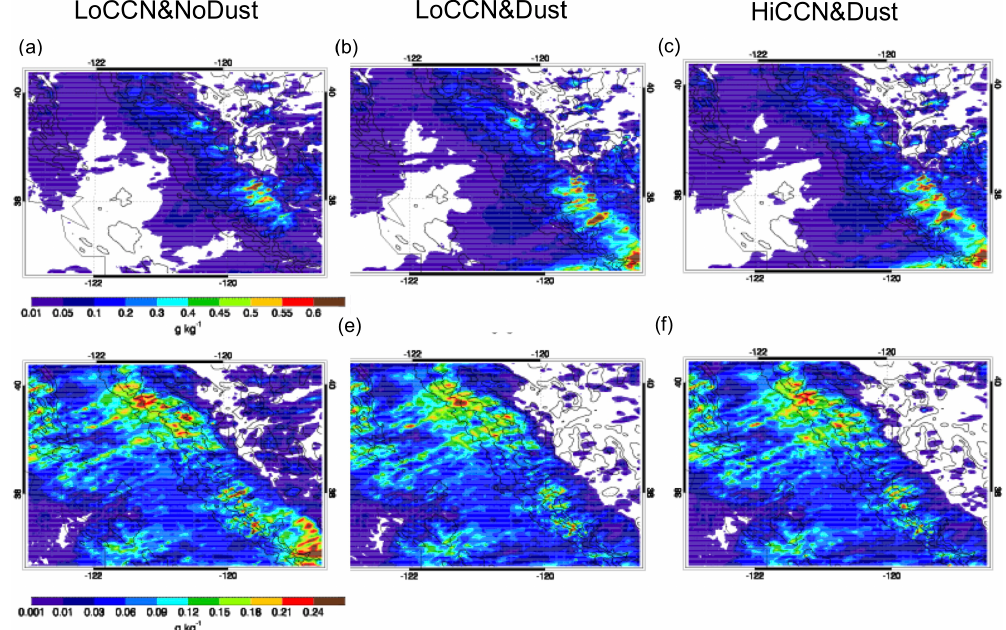
Fig. 10. Same as Fig. 9, except for